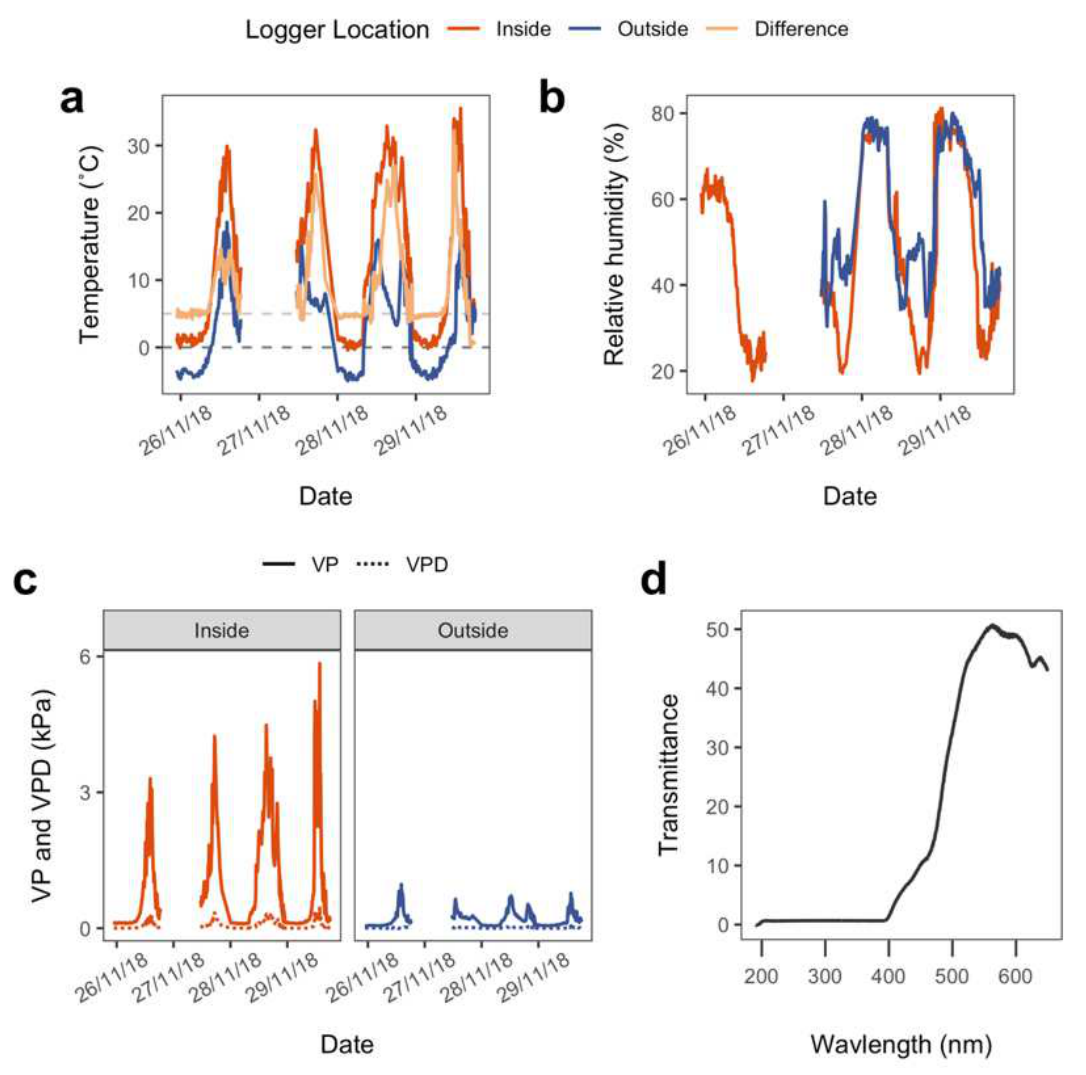
Figure 2. Conditions during the pulse warming experiment, for four days during the period 26th to 29th of November 2018. ( a ) Temperature inside the chamber (blue line), temperature outside the chamber (red line) and the difference between inside and outside temperatures (light orange line) in °C; ( b ) comparison of relative humidity in % inside (blue line) and outside (red line) the chamber; ( c ) water vapour pressure (VP, solid line) and water vapour pressure deficit (VPD, dotted line) in kPa for inside (treatment, blue lines) and outside (control, red lines) the chamber; ( d ) UV-VIS transmission spectra of the chamber material.